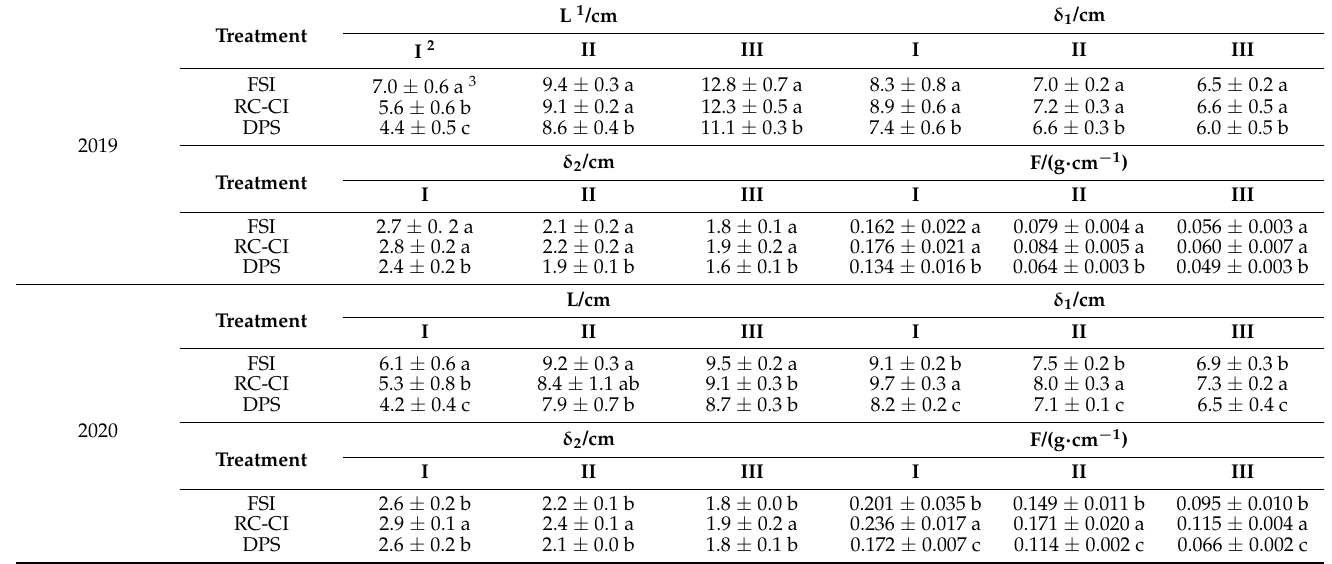
Table 5. Morphological index of rice stem nodes in different irrigation and drainage